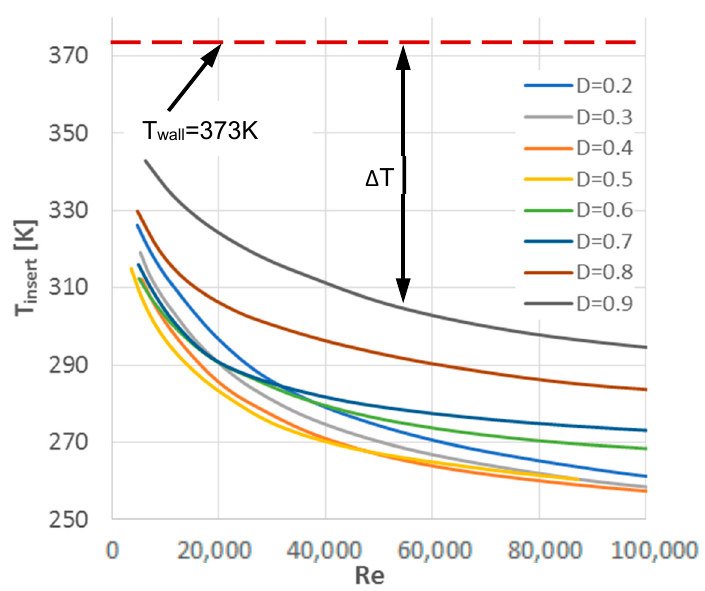
Figure 5. The tested inserts temperatures as a function of the Re number.